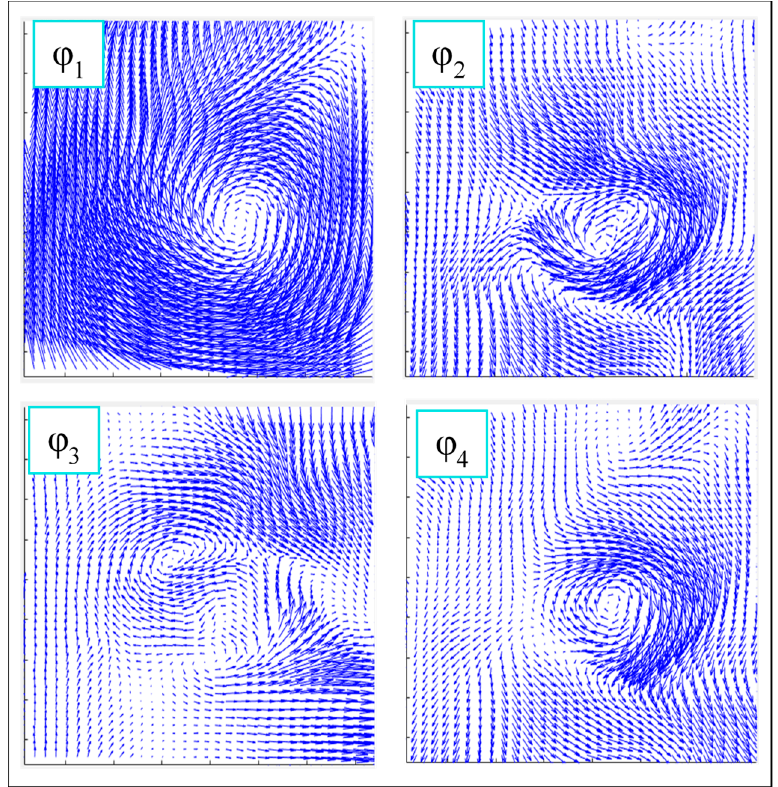
Figure 17. The first four phase-invariant POD modes at valve lift 9 mm.